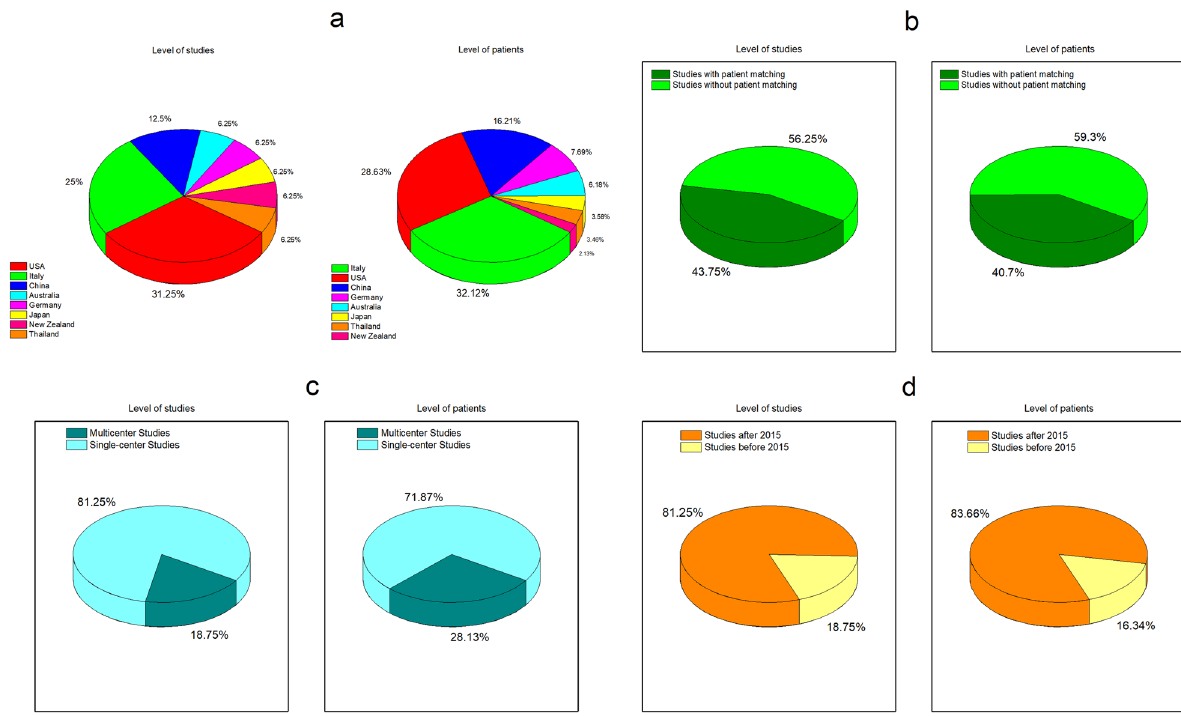
Fig. 2 Pie charts describing at the level of both studies and patients the percentage distribution according to: a . country of origin, b. patient characteristics matching, c . number of contributing referral centers, d . bilevel publication period prior and